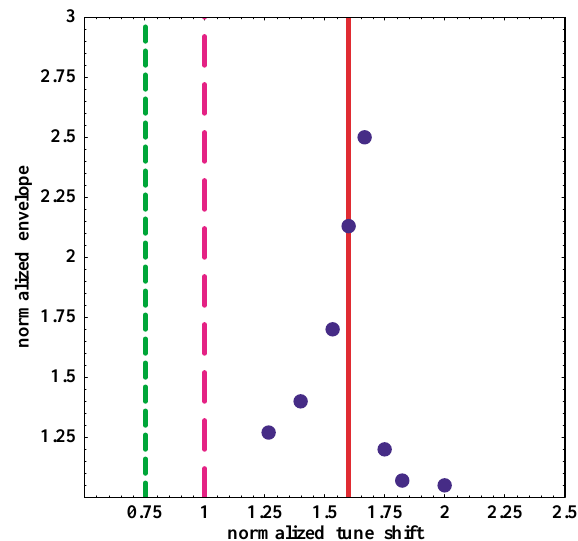
FIG. 4. (Color) Maximum y envelope excursions as a function of normalized tune shift. For each intensity, PIC simulations with the SNS lattice were performed using the code ORBIT (maxi- mum of beam envelope oscillation is plotted with blue dots). The imperfection resonance was excited by introducing gradient error in a single quadrupole.